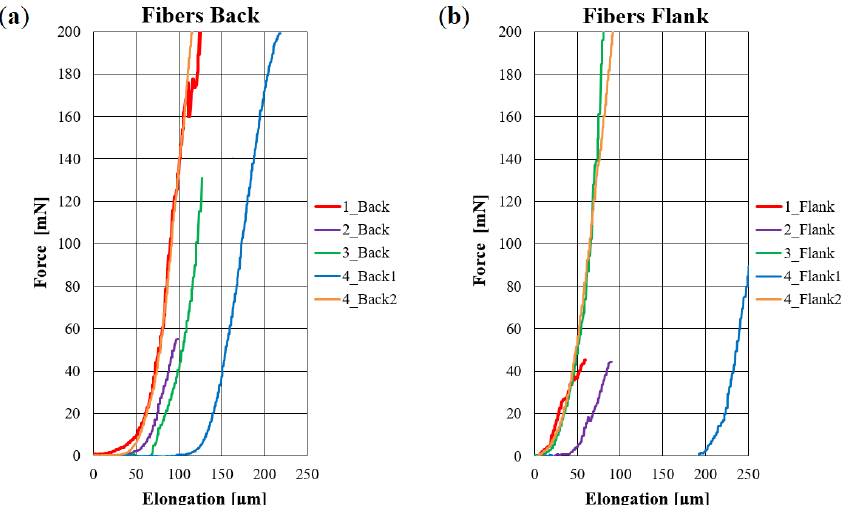
Figure 5. Comparative results of real tensile tests on fiber-bundles with elongations of 5-6% (L1–L3) and up to 17–20% (L4) corresponding to the strength limit: ( a ) Back and ( b )